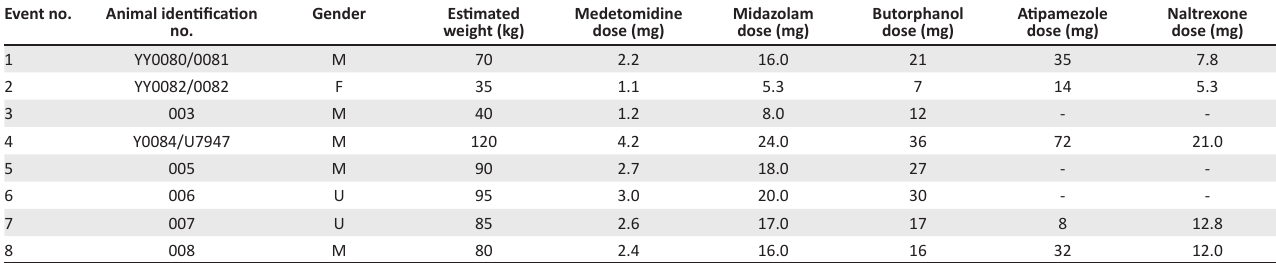
TABLE 1: Doses of anaesthetic agents given to the Cape fur seals during the investigation ( N = 8). Event no. Animal identification